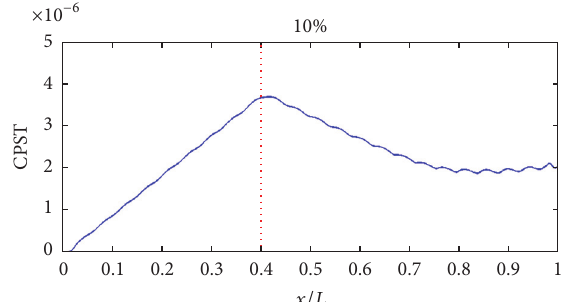
Figure 16: CPST of 10% damaged scenario using displacement response with the mass which is 50 Kg, and the dotted line is for the damage